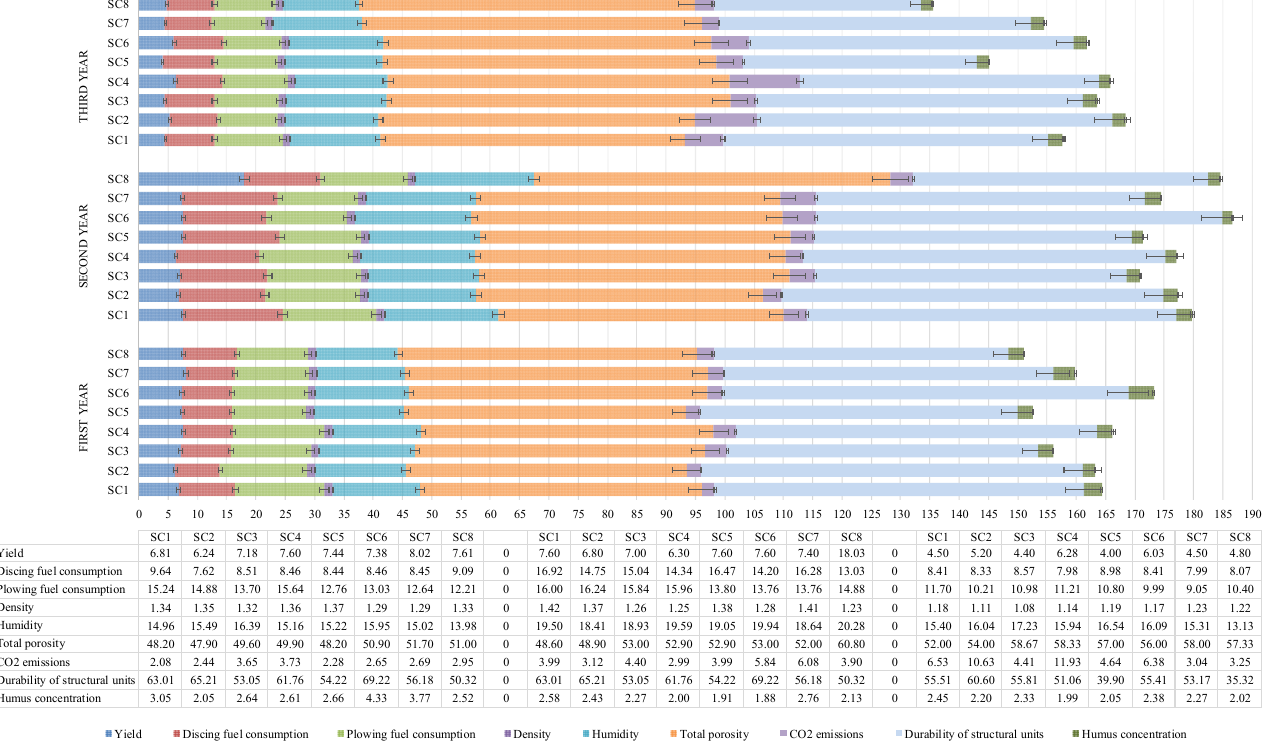
Figure 2. Different parameters of three years dependence on different bio-impact scenarios .